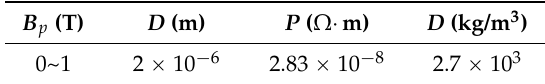
Table 1. Values of the parameters used in Equation (5).